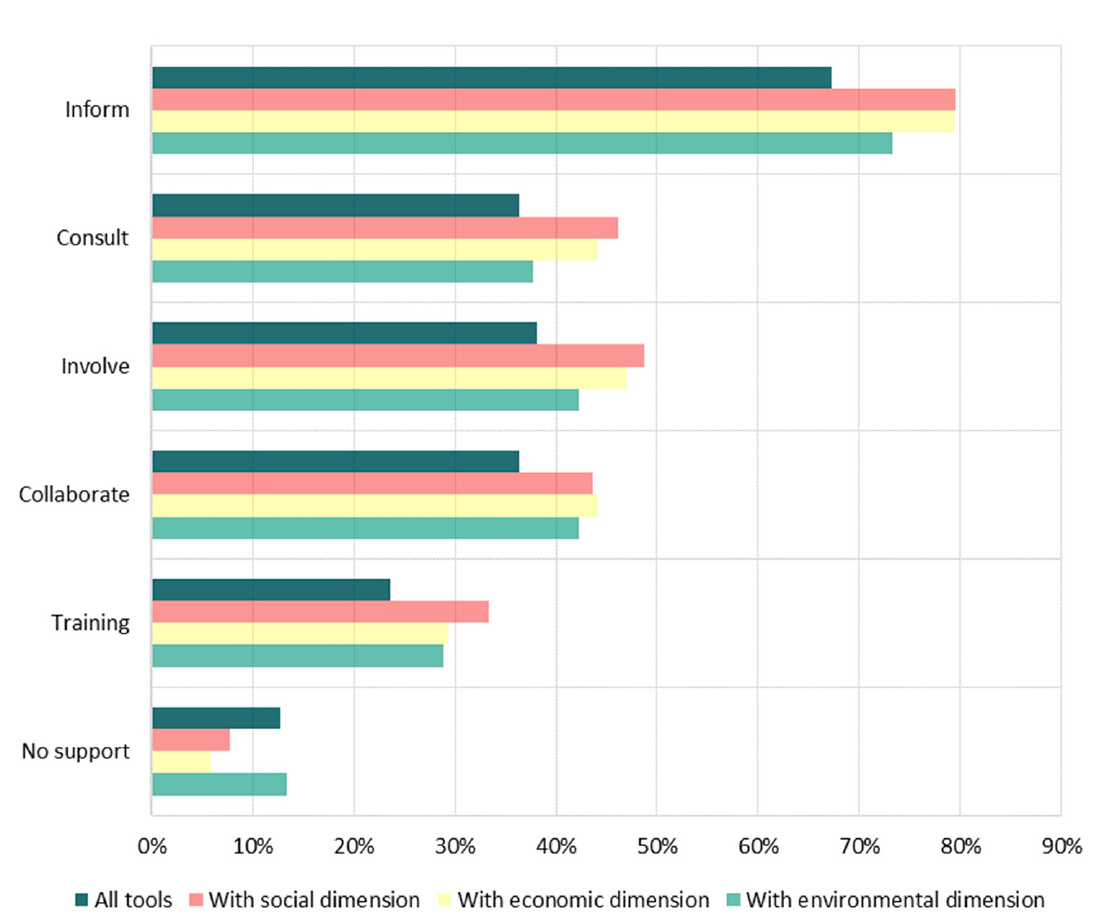
Figure 5. Stakeholder’s level of involvement provided by the tools.